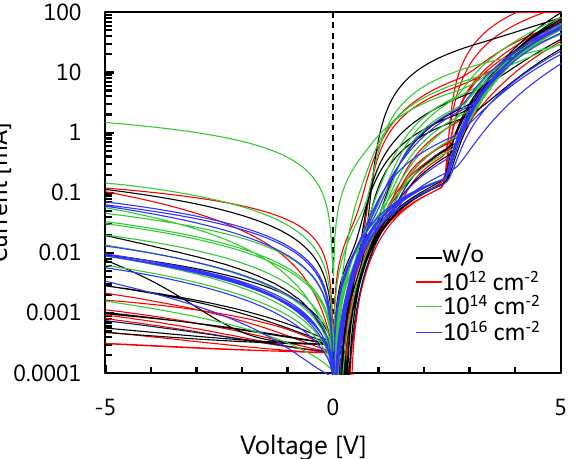
Figure 1. Current–voltage characteristics for the PiN diodes with and without proton implantation at room temperature. The legend indicates the proton